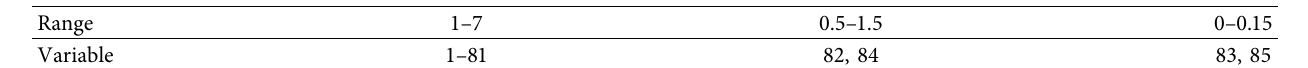
Figure 5: Fuzzy genetic algorithm training process and bar graphs of variables for Kobe earthquake. Table 8: Upper and lower range of variables.